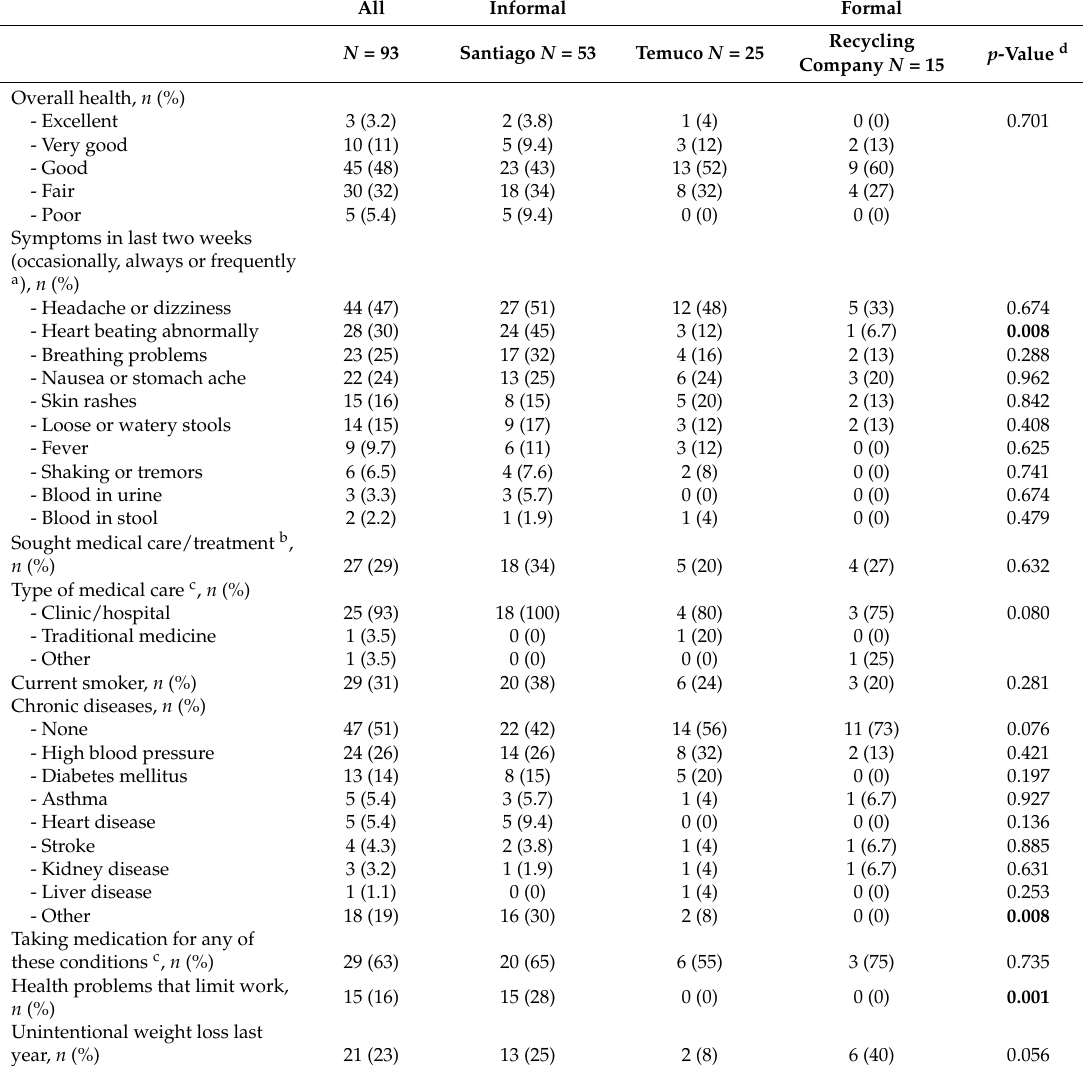
Table 4. Health characteristics of the study population, by job type and